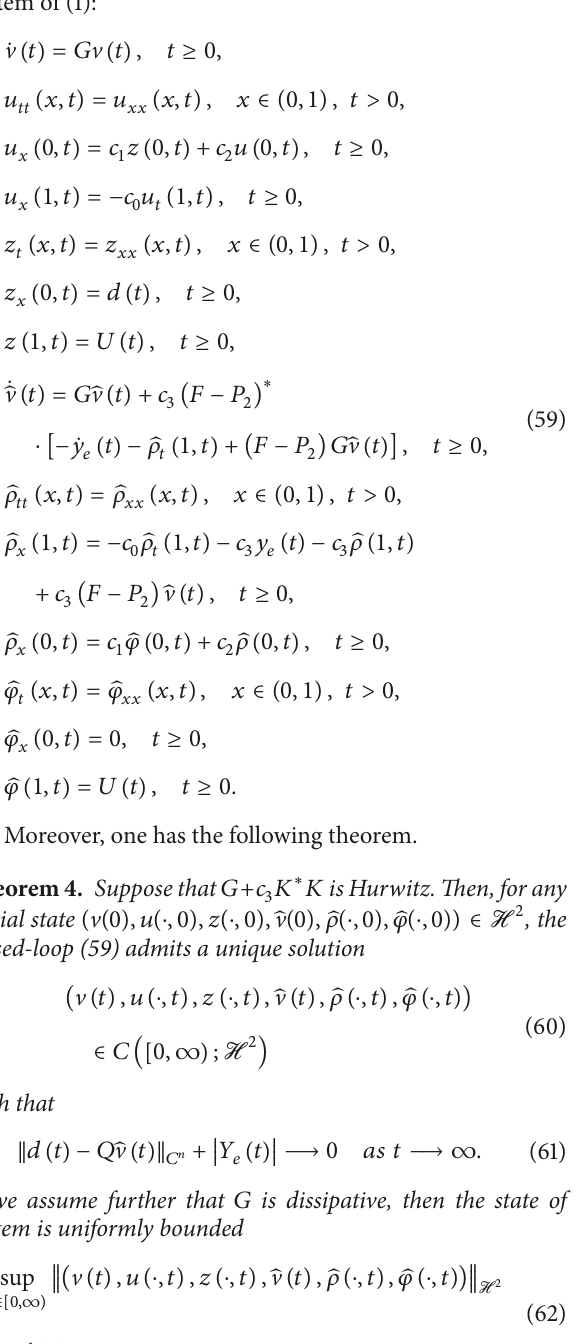
are plotted in Figure 2. In Figures 1 and 2, we choose 𝑐 1 = 0.1 , = 0.7 , 𝑐 = 0.8 𝑐 2 3